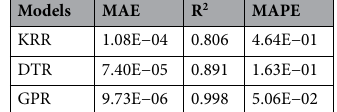
Table 2. The statistical results of all models used in this study.